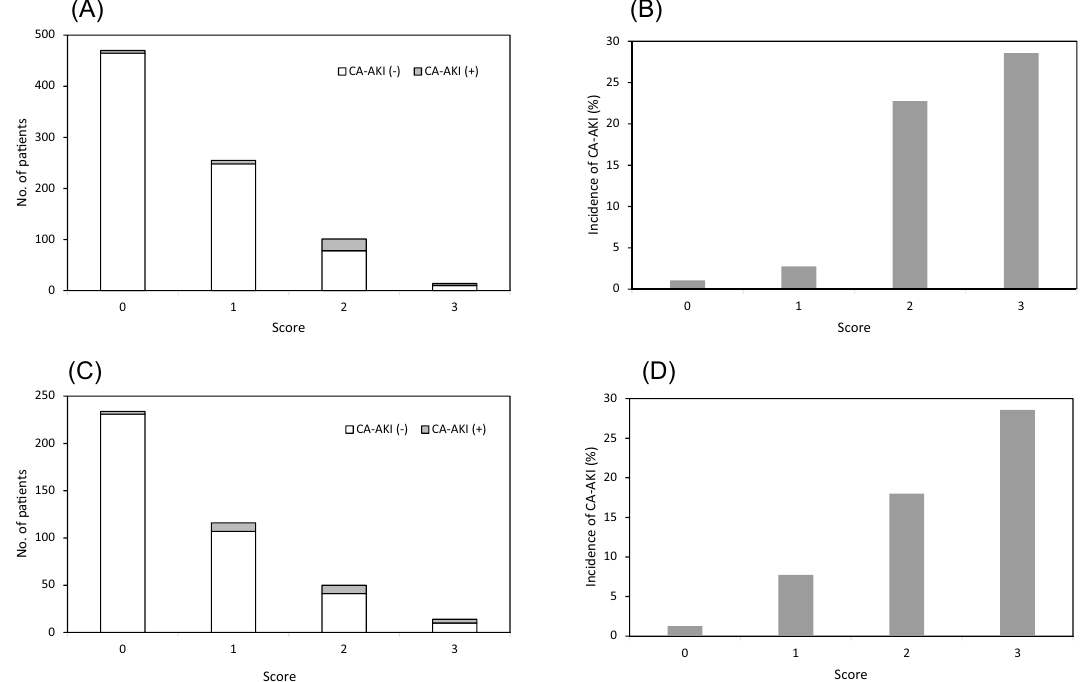
Figure 2. Actual number and incidence of CA-AKI as a function of the risk score. ( A ) Number of patients with CA-AKI and ( B ) incidence of CA-AKI in the derivation dataset. ( C ) Number of patients with CA-AKI and ( D ) incidence of CA-AKI in the validation dataset. An increasing risk of CA-AKI with an increasing risk score is evident. CA-AKI: contrast-associated acute kidney